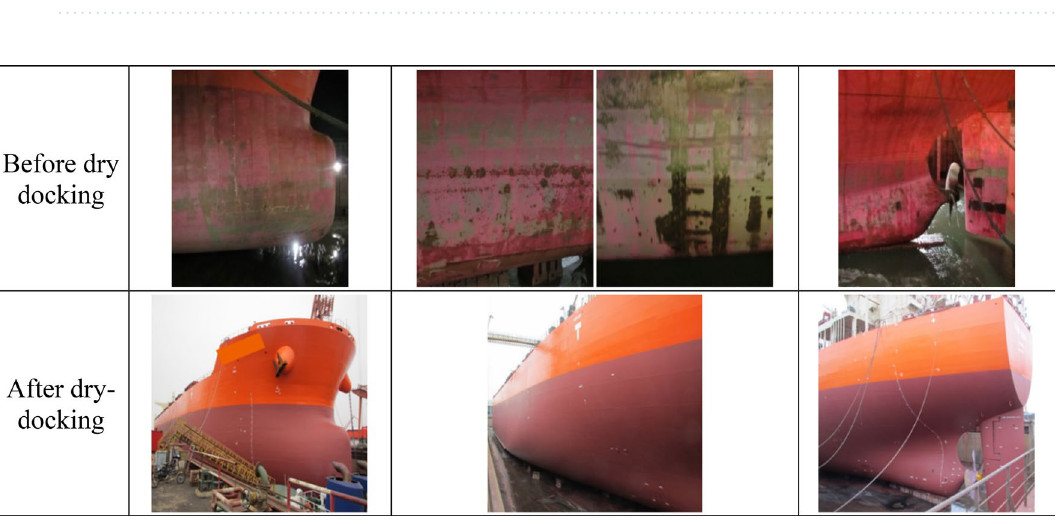
Table 2. Key events and service periods for the 176 k DWT bulk carrier.